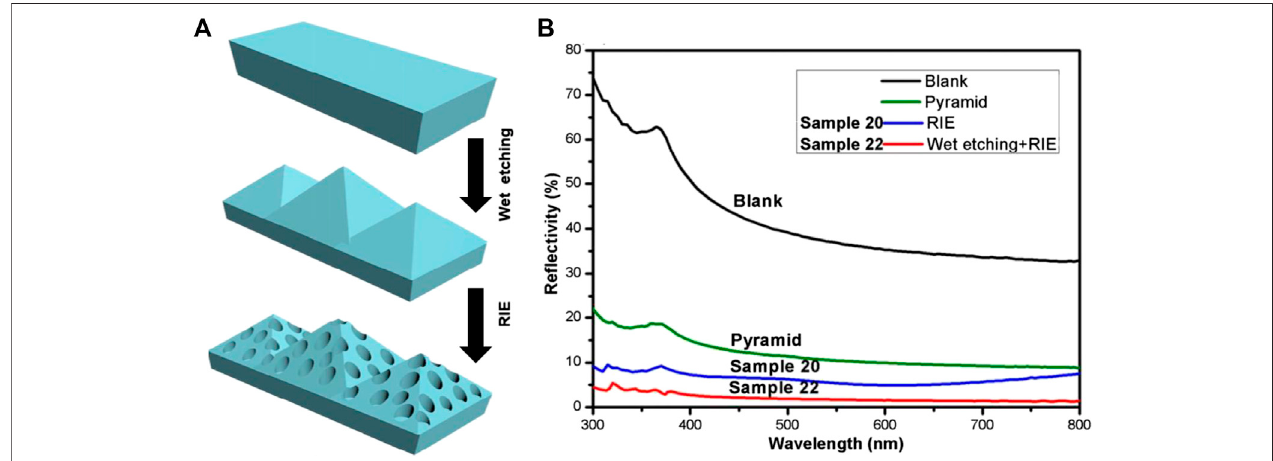
FIGURE 9 | (A) The surface of silicon etched by wet etching and RIE. (B) Re fl ectivity of different kinds of silicon surface. Source : reproduced from Ref. 77.